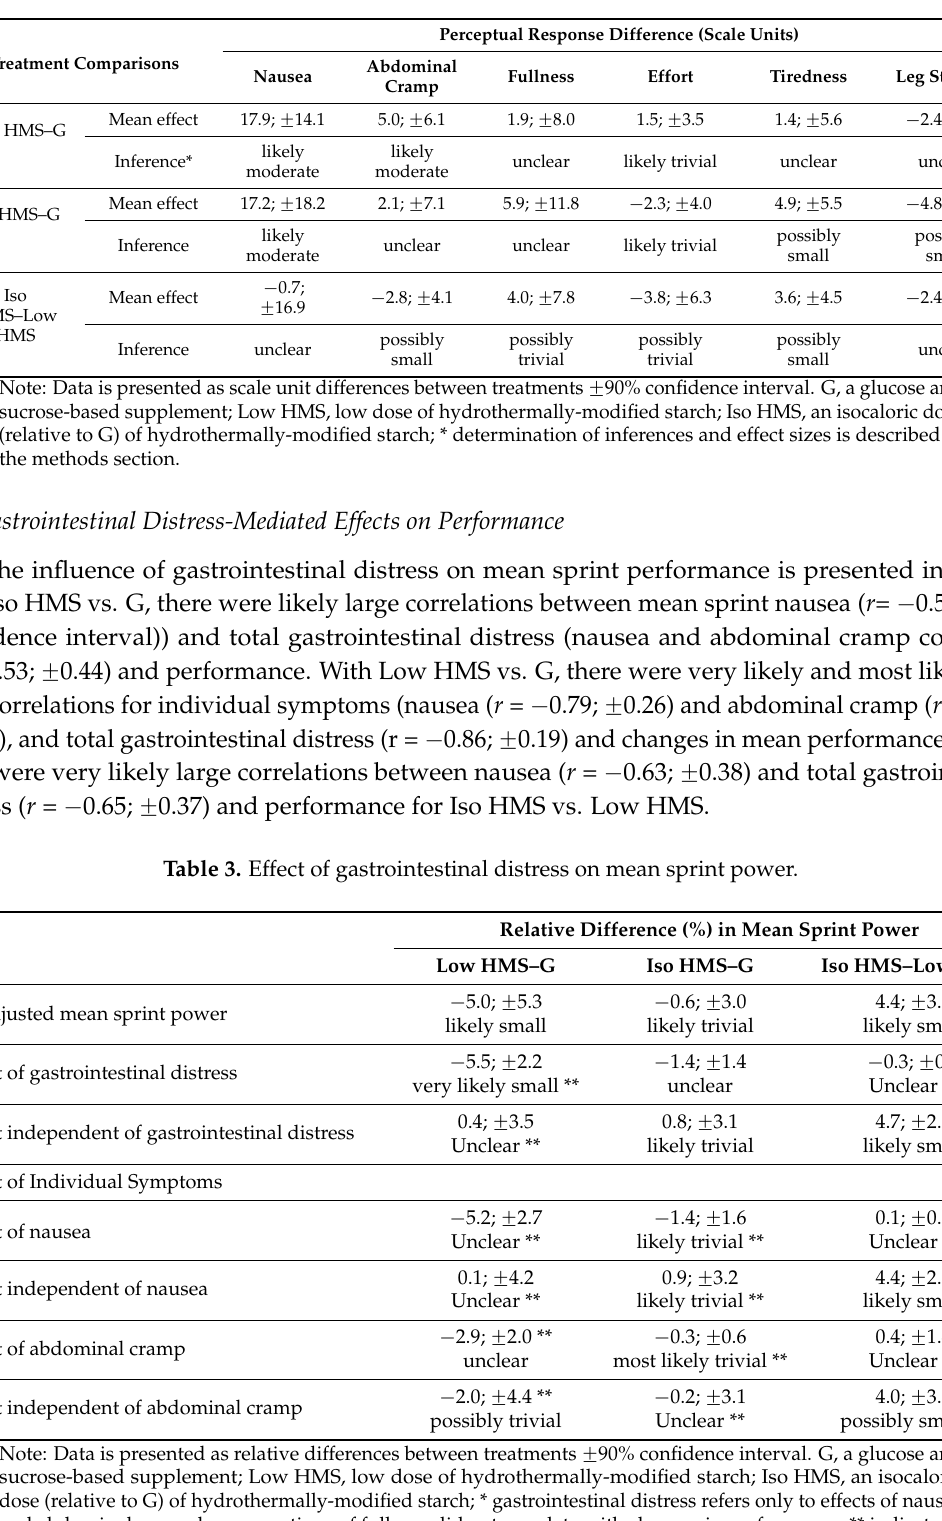
Table 2. Pairwise comparisons for perceptual responses during repeated sprints.